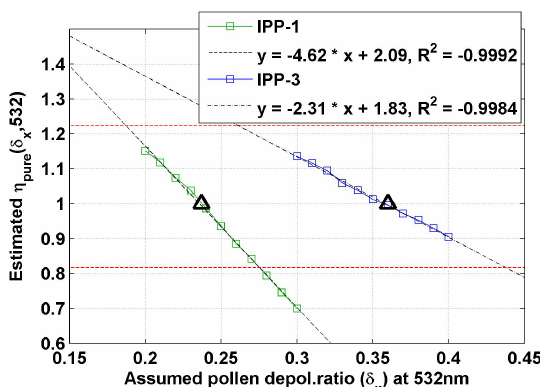
Figure 11. Estimated η pure against the related assumed pollen de- polarization ratio δ x at 532nm for IPP-1 (in green) and IPP-3 (in blue). Linear regression lines are drawn by dotted lines, with fitting equations shown. The correlation coefficient ( R 2 ) values are also given. η is a parameter using backscatter-related Ångström expo- nents between 355 and 532nm (Eq. 6), and η pure is the estimated η value for χ pollen (δ x ) = 1 (i.e. the pollen contribution in the ob- served aerosol particle population is 100%) (Eq. 8). The final re- sults for pure pollen are shown by the black triangles. η pure val- ues of 0.82 and 1.22 (i.e. backscatter-related Ångström exponent of − 0 . 5 and 0.5) are shown by horizontal dotted red